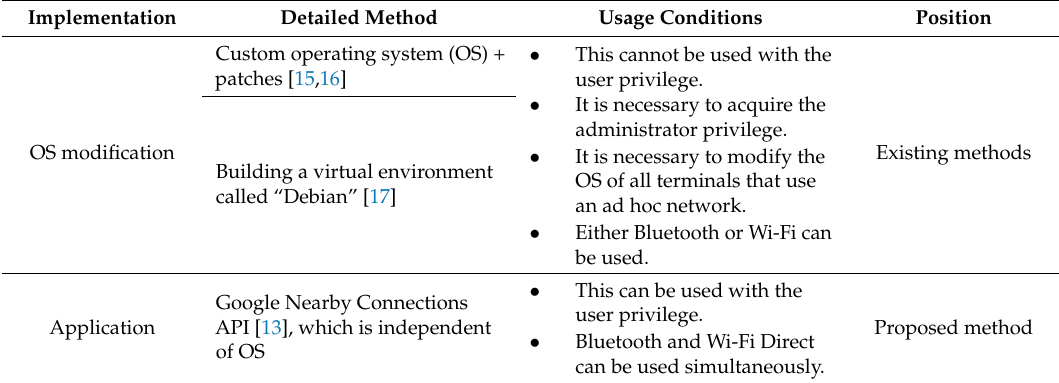
Table 2. Methods of building an ad hoc network with Android